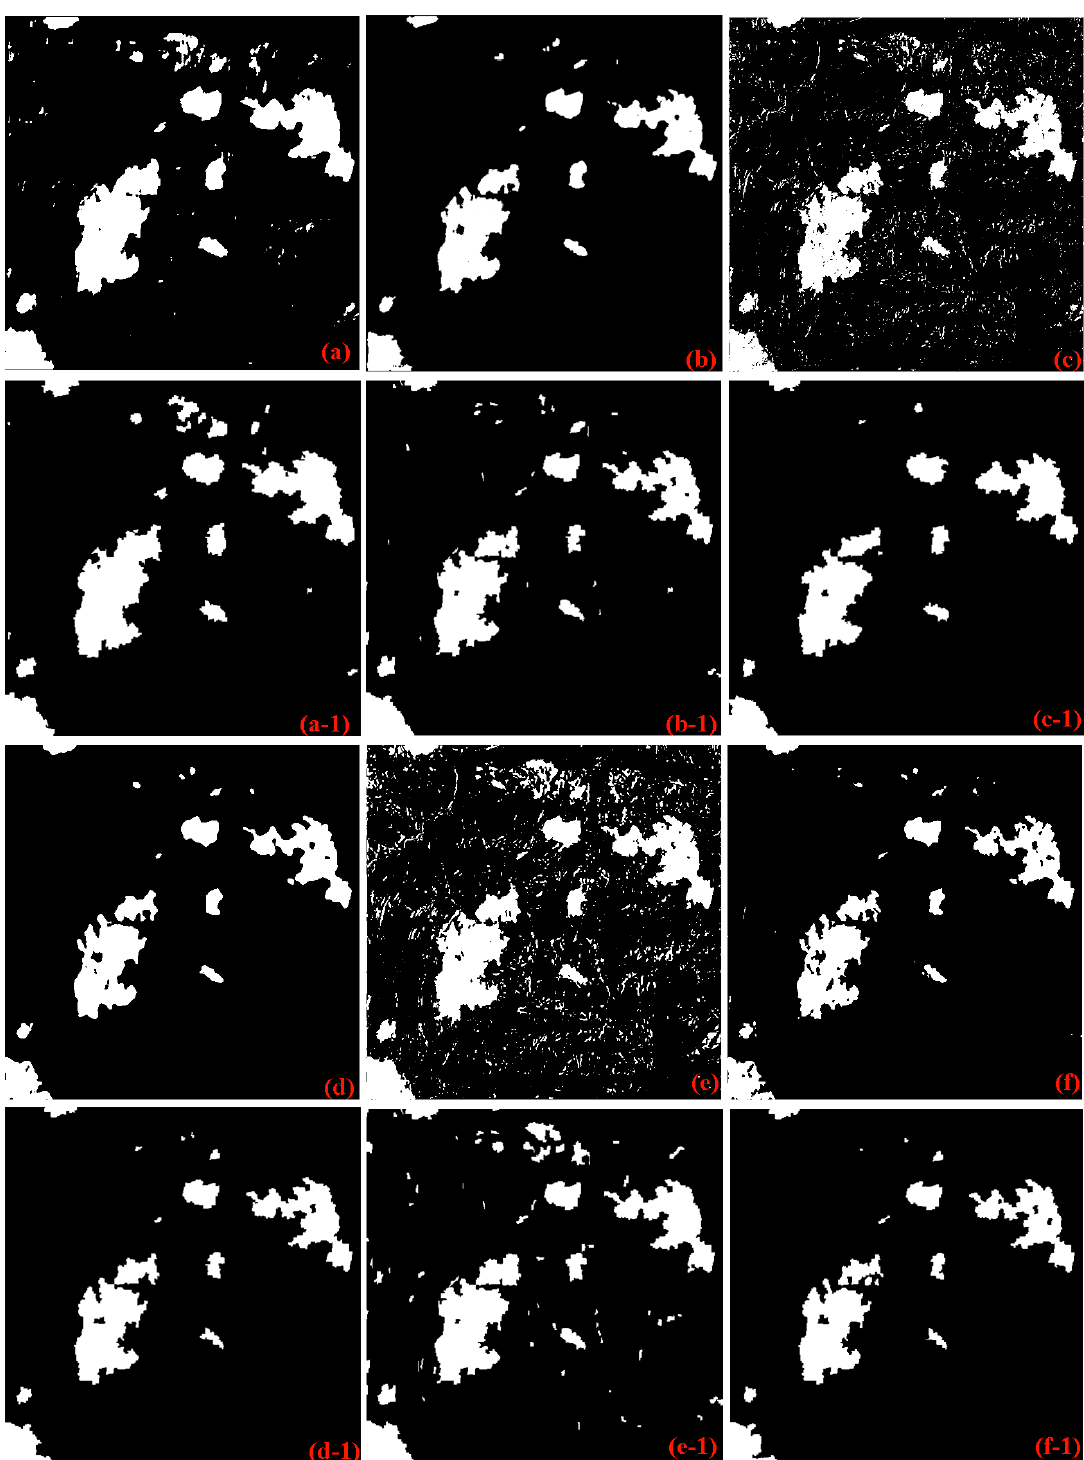
Figure 10. LCCD maps obtained by the preprocessing methods and the proposed OBEM algorithm for the second data set (Landsat TM images): ( a ) GWDM_EM; ( b ) GWDM_FCM; ( c ) CVA_EM; ( a-1 ) GWDM_EM+OBEM; ( b-1 ) GWDM_FCM+OBEM; ( c-1 ) CVA_EM+OBEM; ( d ) MRF_EM; ( e ) LSELUC; ( f ) PCA_Kmeans; ( d-1 ) MRF_EM+OBEM; ( e-1 ) LSELUC+OBEM; and ( f-1 ) PCA_Kmeans+OBEM.